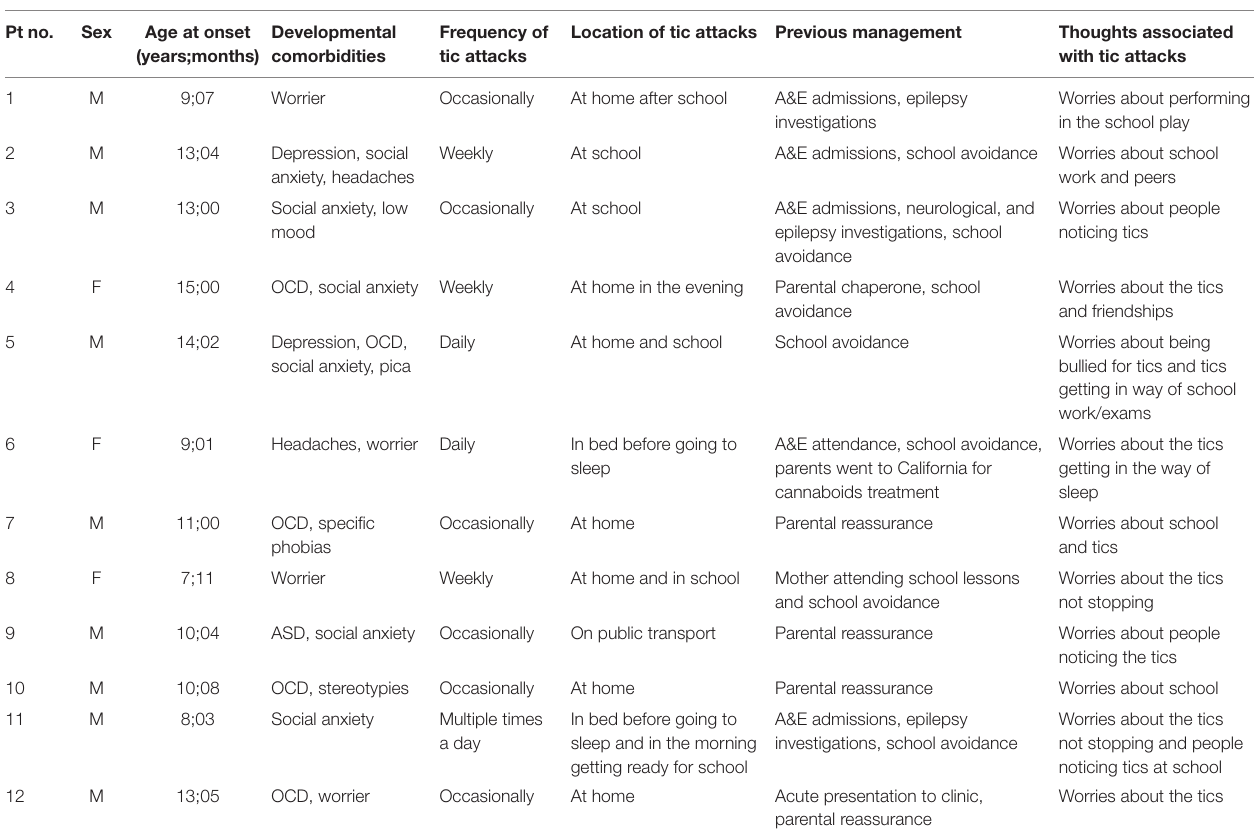
taBLe 1 | patient characteristics and features of tic attacks. pt